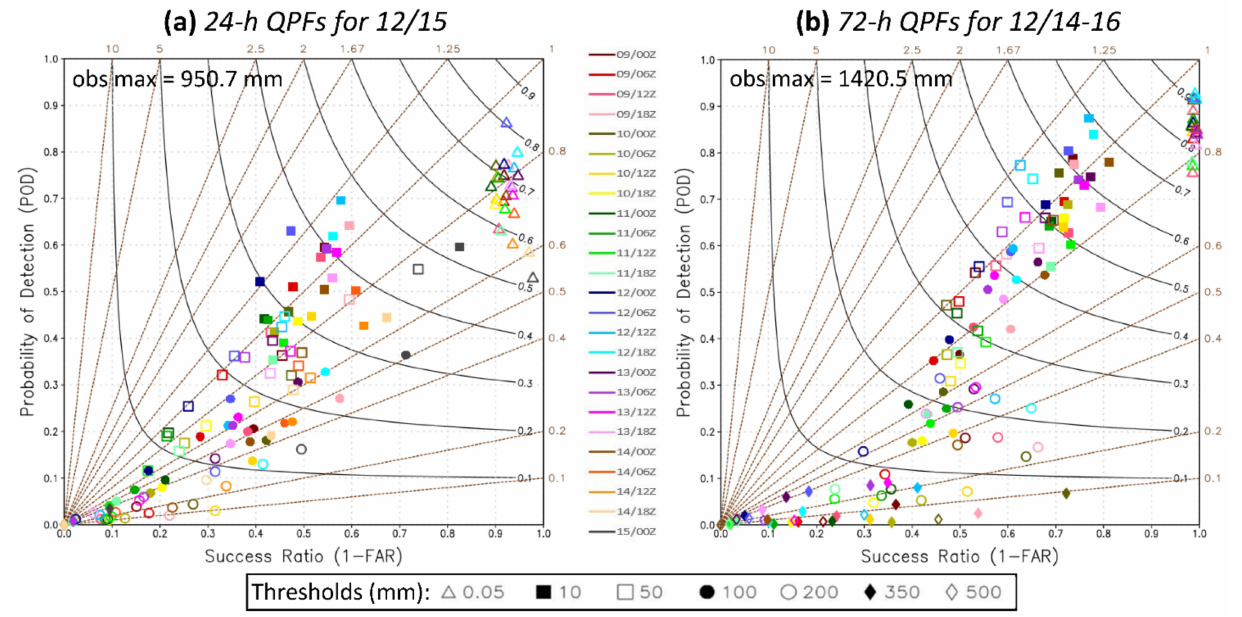
Figure 17. As in Figure 12, except for ( a ) 24 h QPFs targeted for 15 December and ( b ) 72 h QPFs for the combined period of 14–16 December (all times in UTC) during TY Melor